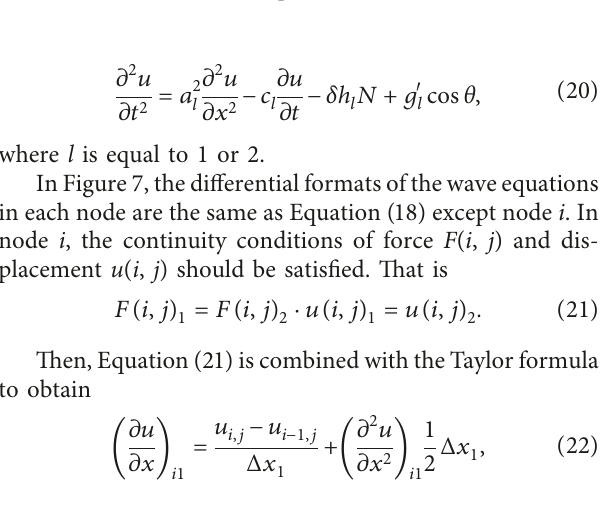
Figure 7: Sketch map of sucker rod